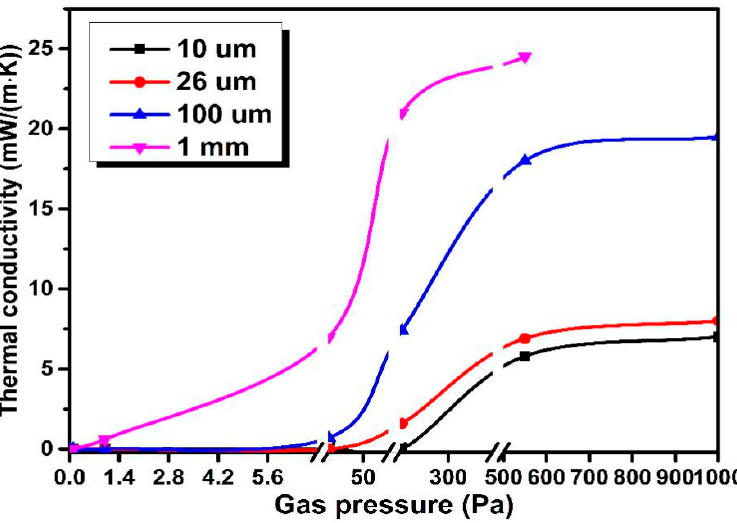
ff erent pore sizes as a function of gas Figure 13. Gaseous conductivity with different pore sizes as a function of gas pressure. Figure 13. Gaseous conductivity with di